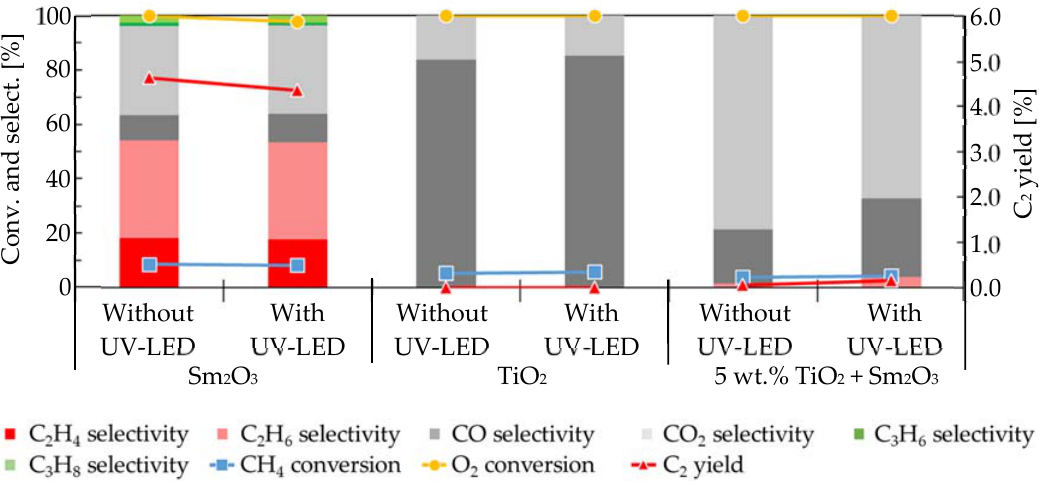
Figure 1. E ff ect of UV-LED irradiation on the oxidative dehydrogenation of methane when using Sm 2 O 3 , TiO 2 , and 5 wt.% TiO 2 + Sm 2 O 3 .